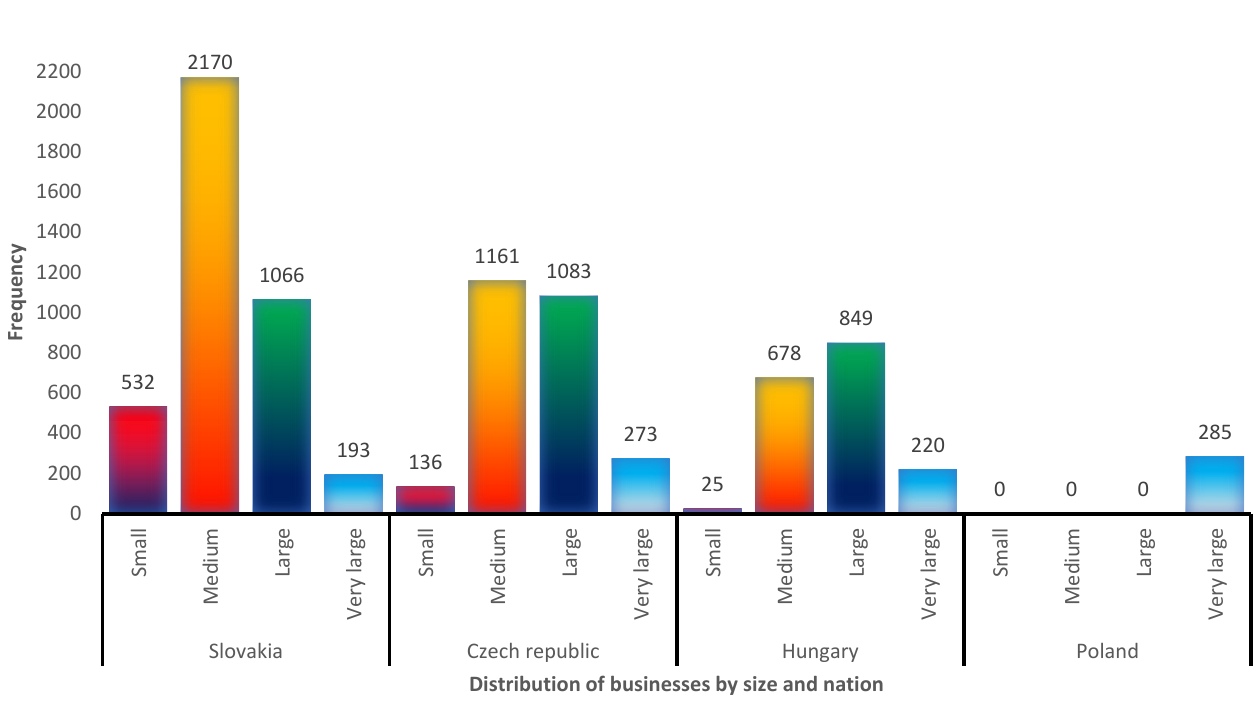
Figure 3. Size and national structure of the enterprises. Source: own research. Figure 4 indicates the profitability indicators that were calculated.